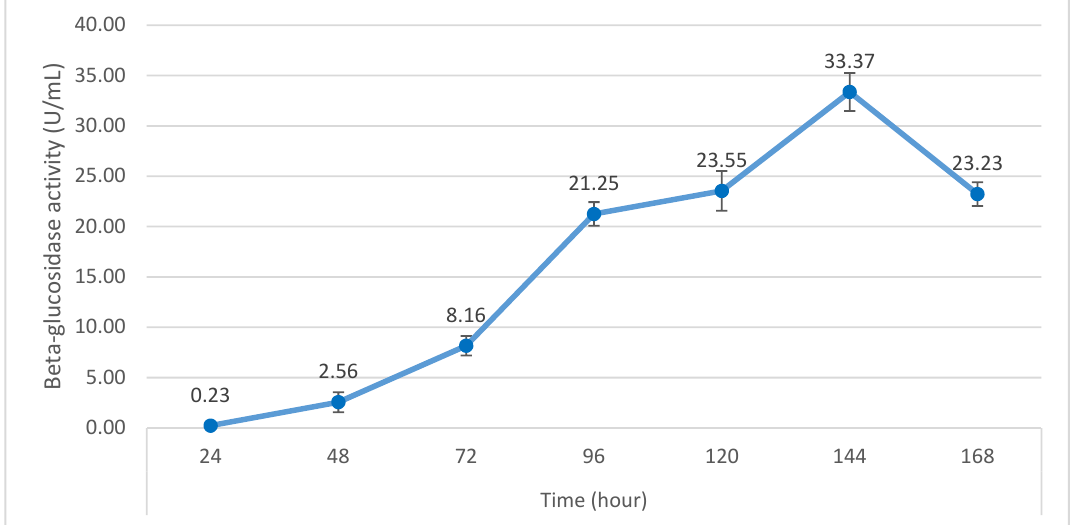
Figure 4. Effect of different carbon sources on β -glucosidase activity of P. citrinum . 3.4. Fermentation of Soybean Residual Extract by P. citrinum for Aglycones (Genistein, Daidzein) Production Figure 5 and Table 1 show that soybean residual extract originally contained glucosides, which were still dominant in the first 24 h fermentation, but partly hydrolyzed after 48 h and completely converted to aglycones after 72 h fermentation. Moreover, the data revealed that at 10–20% (v/v) volumetric ratio of P. citrinum inoculum to CDN substrate, the transformation into aglycones from glucoside forms complete took place during 72 h of fermentation (Table 2). This indicates that the